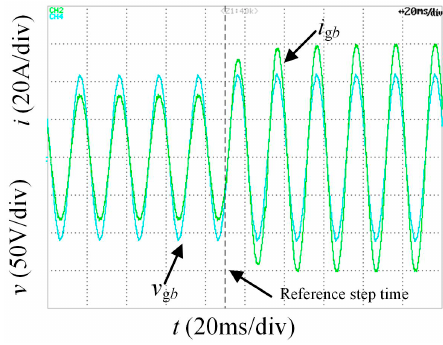
Figure 16. Transient response of the proposed grid-connected inverter.